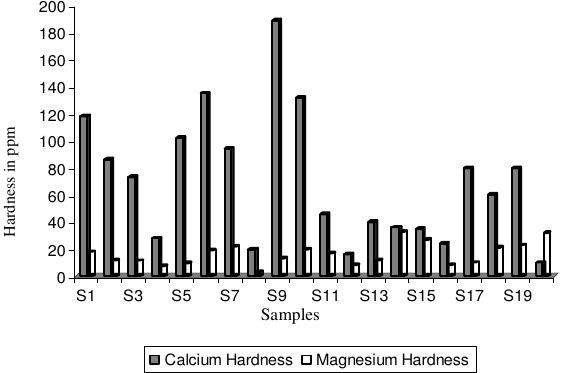
Figure 3. Calcium and magnesium hardness (ppm) of water samples collected from Kandarvakottai (S1 to S10) and Karambakudi (S11 to S20) areas.